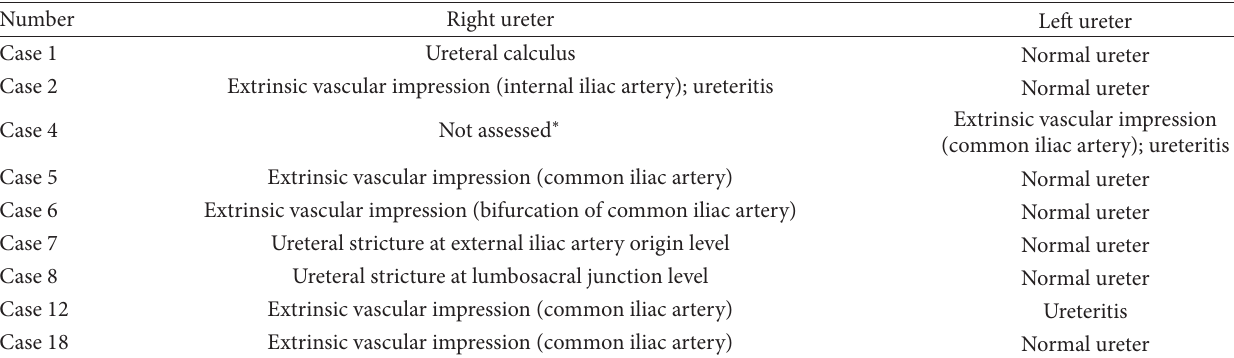
Table 2: Causes of ureteral dilatation on CT Urography ( 𝑛 = 9 ).